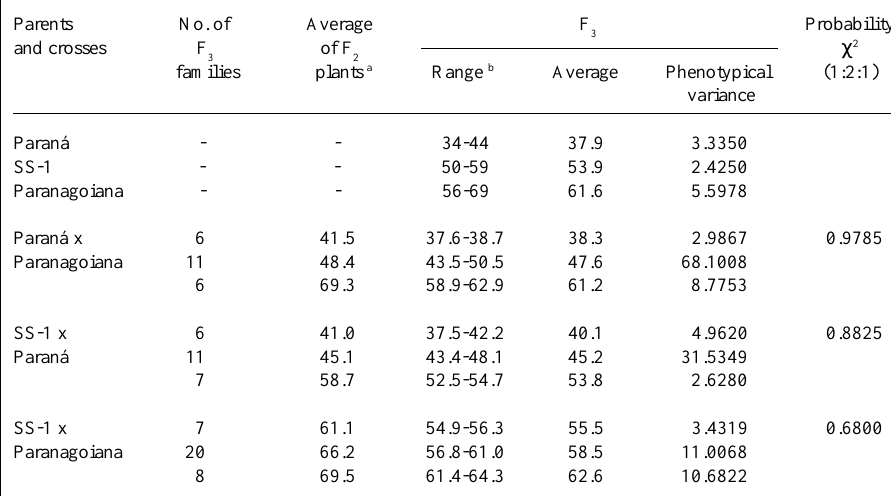
Table I - Classification of F soybean families according to the average of F 3 phenotypical variance of number of days to flowering in comparison to the parents of crosses Paraná x Paranagoiana, SS-1 x Paraná, and SS-1 x